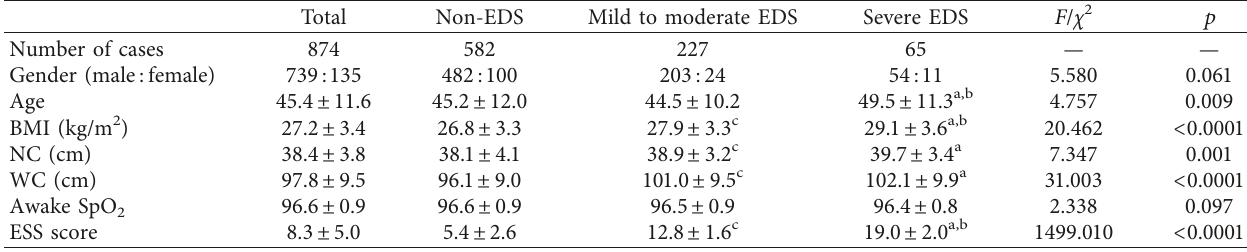
Table 1: Demographic characteristics of the total OSA patients and the patients with different severities of EDS. Total